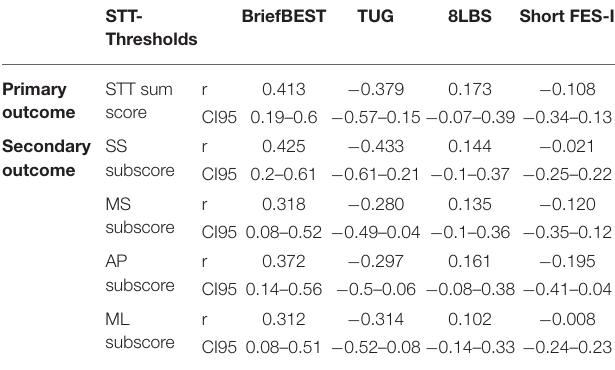
TABLE 3 | Correlation between STT sum score and subscores (ACE) and reference measures. STT- BriefBEST TUG Thresholds